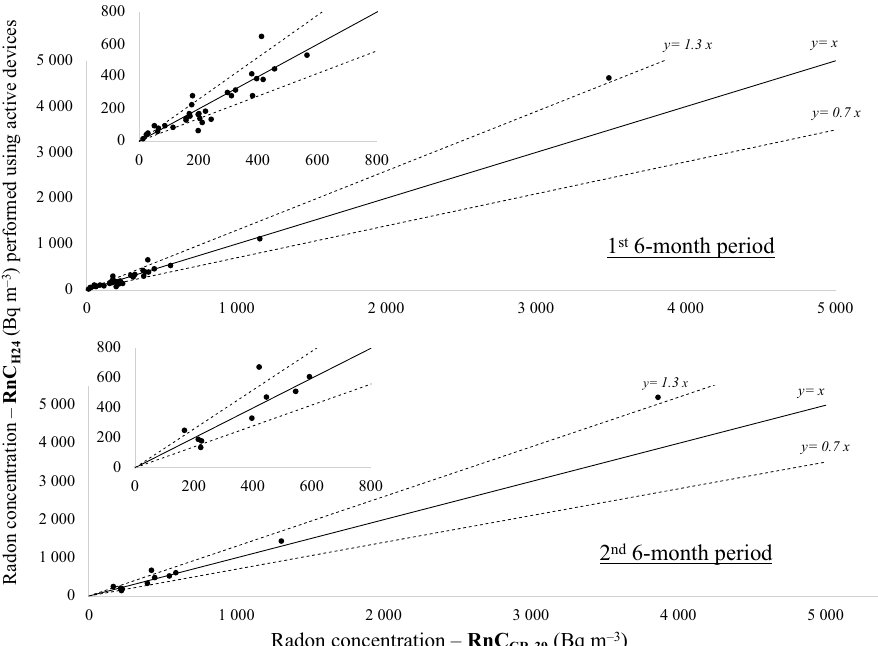
Figure 2. Comparison between average radon concentrations results measured using passive radon devices (x-axes) and active devices (y-axes) both for first (above) and the second 6-month period of exposure (below). The smaller plots are a zoom in the range 0–800 Bq m –3 .